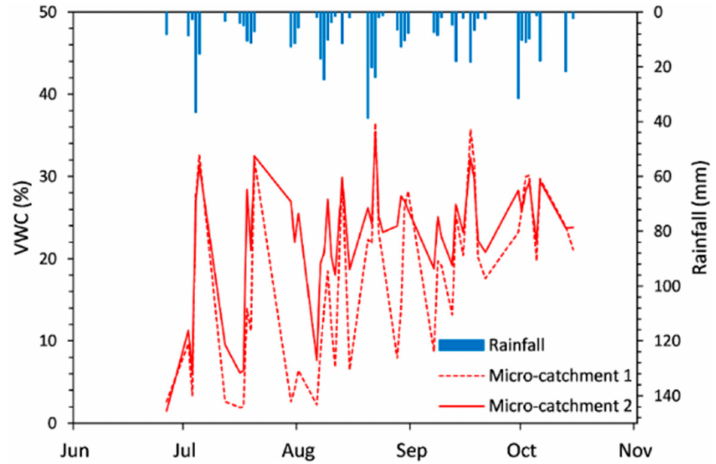
Figure 8. Mean soil moisture by rainfall event after thinning (2019) for micro-catchments 1 and 2. Rainfall events in 2019 started on 10 June, but similar to 2018, small rainfall events did between 10 June and 3 July, with a mean of 1.1% (s.d. = 0.8%). Rainfall began to increase